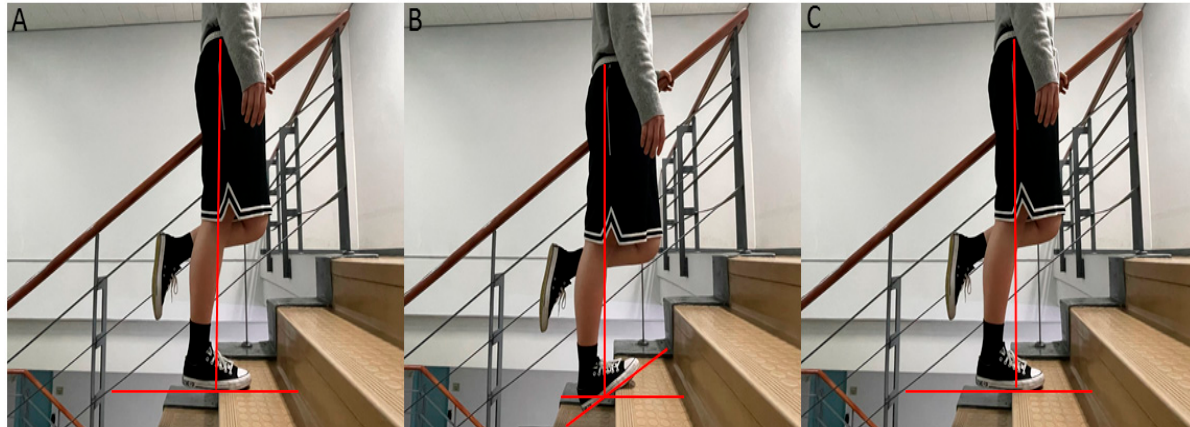
Figure 2. While standing on the dominant leg ( A ), the gastrocnemius muscle was eccentrically contracted by lowering the heel as much as possible with the knee extended ( B ), and then returned to baseline to repeat the contraction ( C ). The vertical line represents the line of gravity, and the horizontal lines represent the ankle at the neutral and maximum degrees of dorsiflexion.